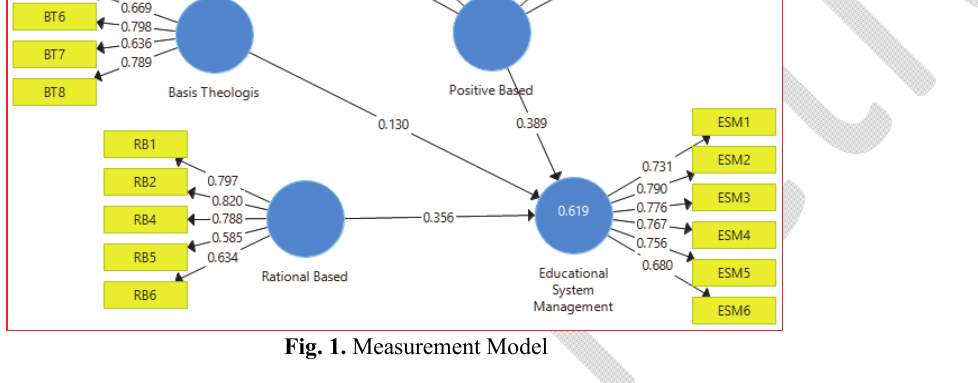
Fig. 1. Measurement Model